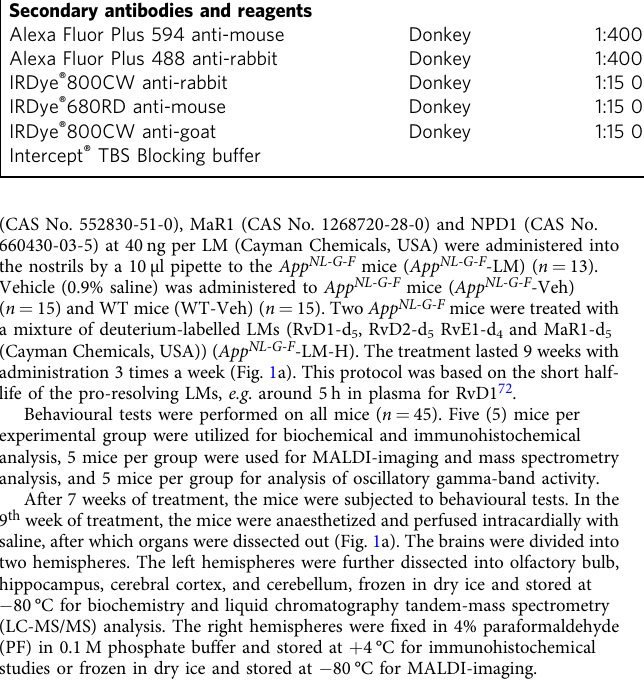
− 80°C for biochemistry and liquid chromatography tandem-mass spectrometry (LC-MS/MS) analysis. The right hemispheres were fi xed in 4% paraformaldehyde